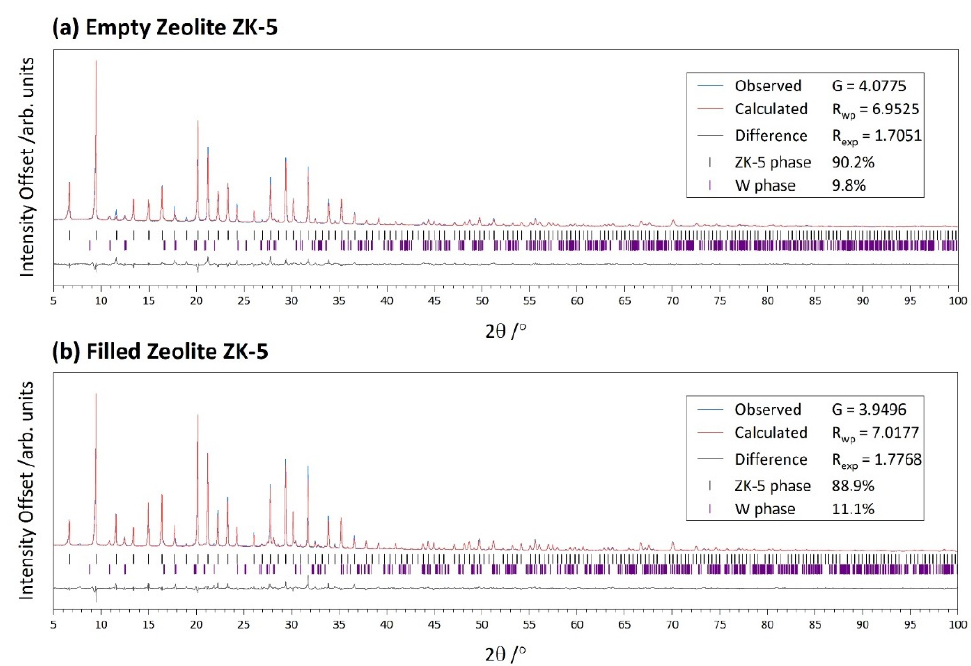
Figure 5. Powder X-ray diffraction patterns for the ( a ) empty and ( b ) filled zeolite ZK-5 samples. The experimental data are shown in blue, the Rietveld fit in red and the difference between the two in grey. Bars in black indicate Bragg peaks belonging to the ZK-5 phase, and purple to the impurity W phase. The incident X-ray radiation wavelength was 1.5406 Å. Table 5. Final refined unit cell parameters and crystallographic sites for the empty zeolite ZK-5 sample. ‘Occ.’ refers to the fractional occupancy of the relevant crystallographic site. Error in paren- theses.